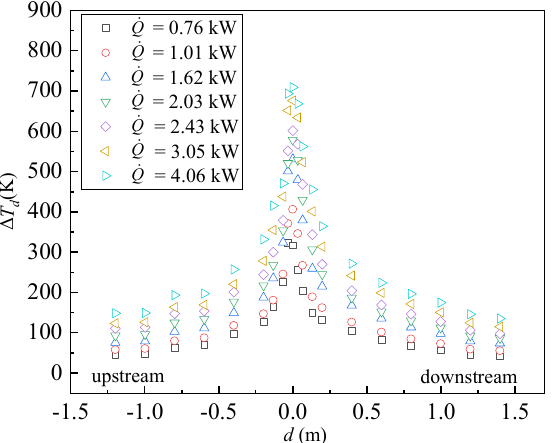
Figure 7. Longitudinal attenuation of the temperature of the longitudinal direction in a straight tunnel ( R = ∞).